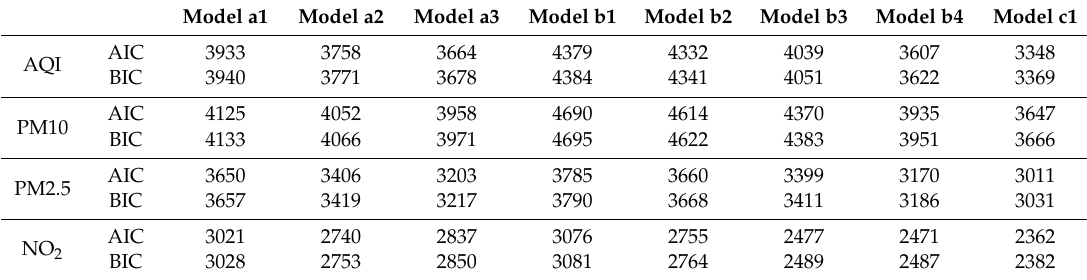
Table 4. AIC and BIC scores of the models.